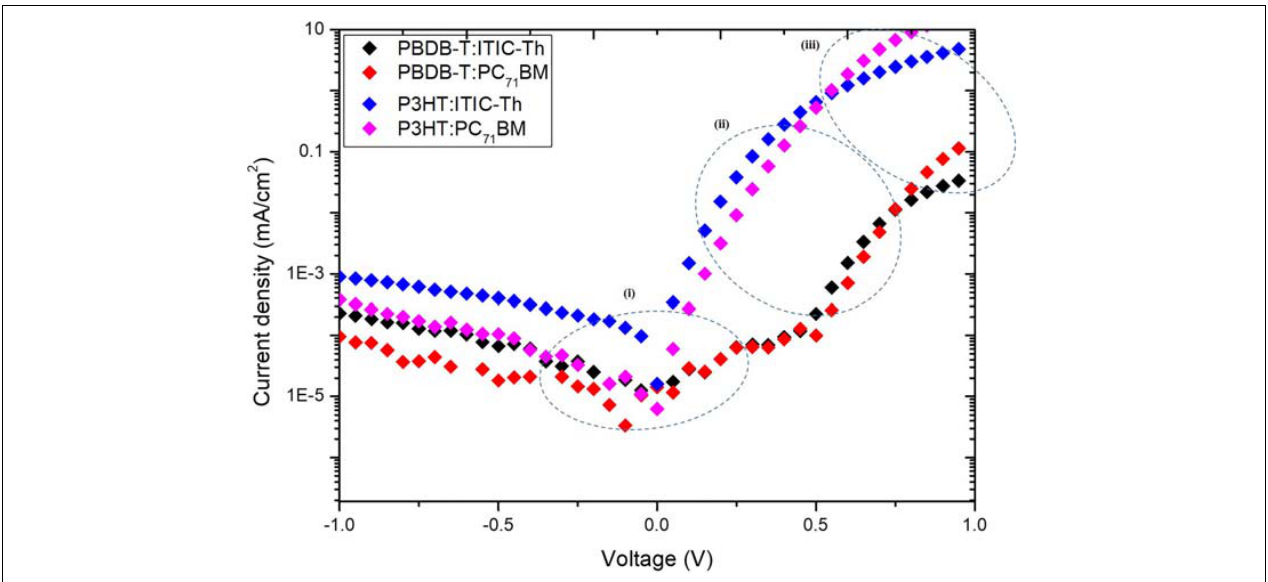
FIGURE 5 | Semi-logarithmic current density vs. voltage characteristics of various blends.